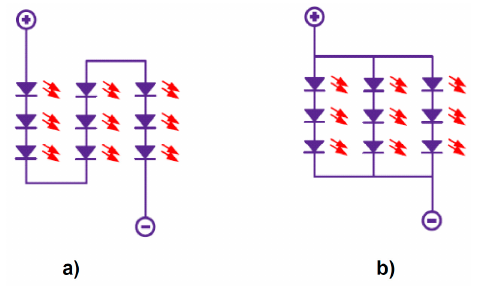
Figure 4. Typical electrical configurations of the arrays of blue LED chips within a CoB LED device package: ( a ) A single string of serially connected LED chips, ( b ) parallel connection of multiple serially connected strings of LED chips. (After [36]).